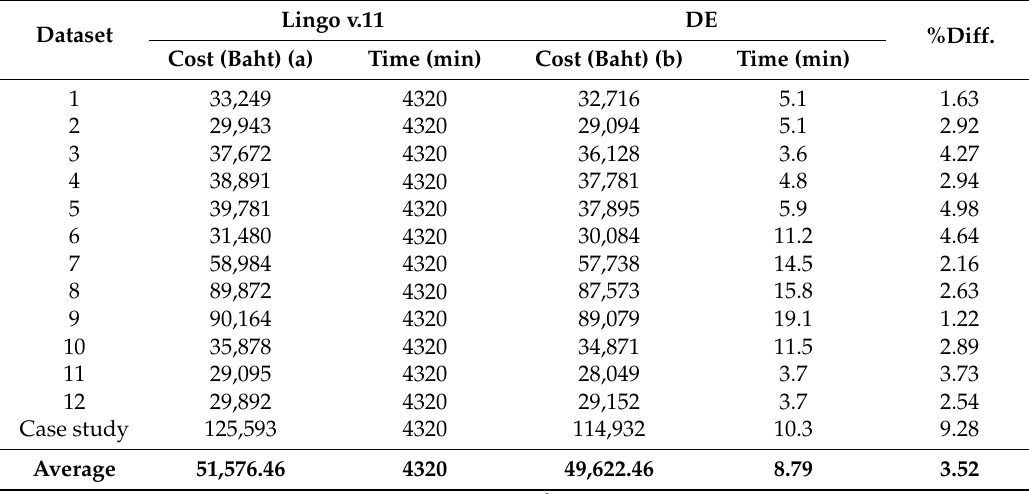
Table 19. Experimental results for large samples (20 × 20) and the case study showing the cost of assignment and processing time.